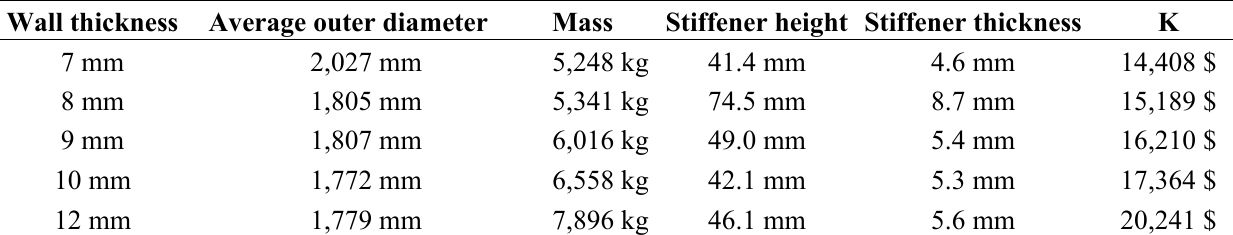
Table 8. Optimization results for the top segment.